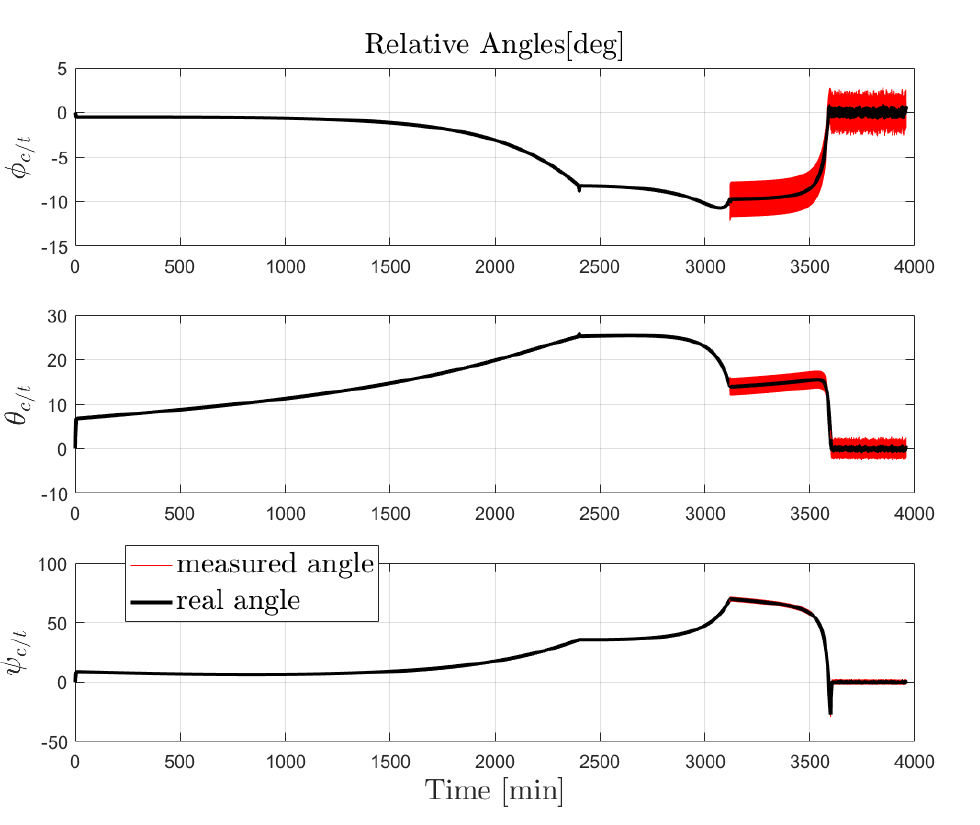
Figure 30. Relative